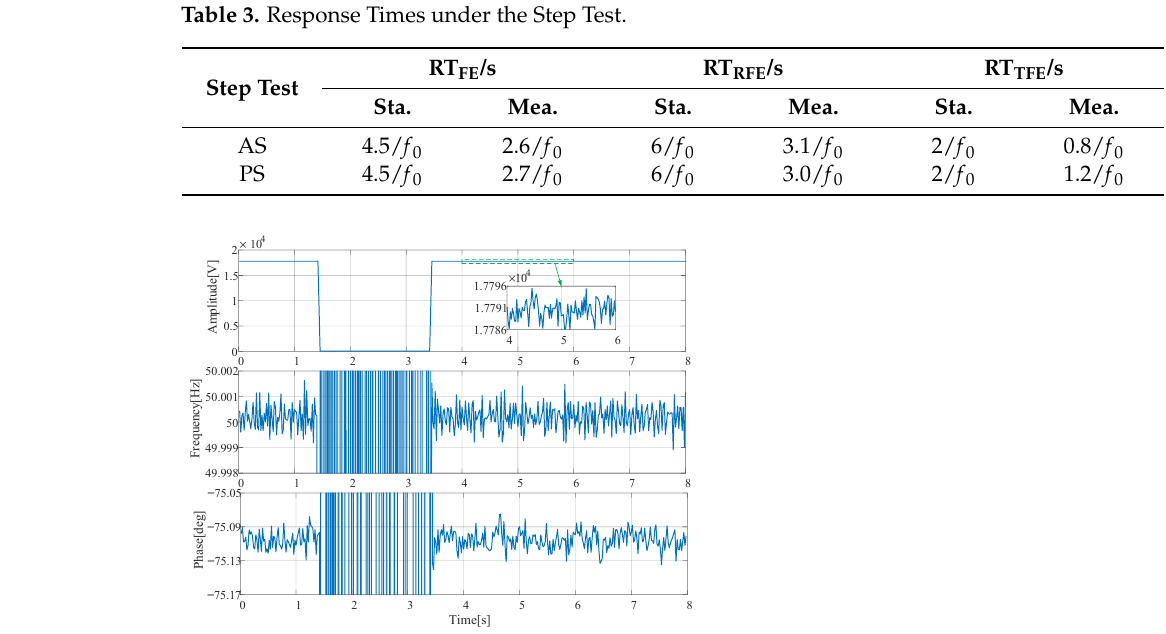
Table 3. Response Times under the Step Test.